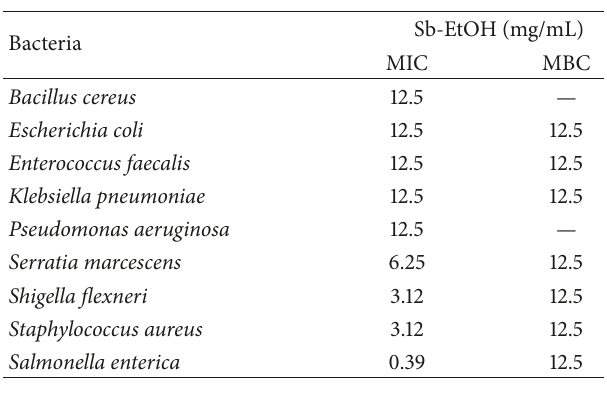
Table 4: Antimicrobial activity of the extract of Schinopsis brasilien- sis.